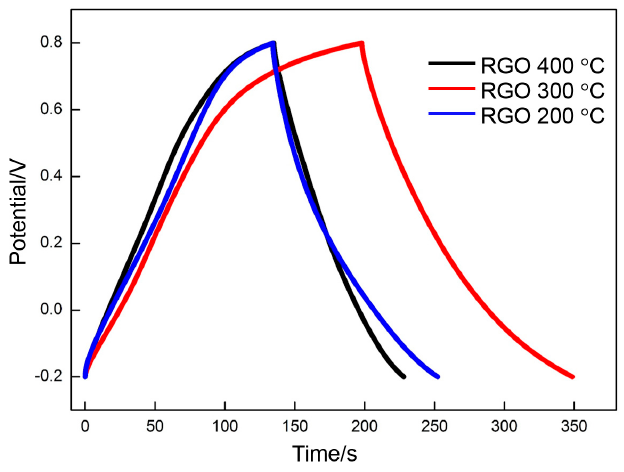
Figure 12. Galvanostatic charge/discharge curves of RGO at different deposition voltages.